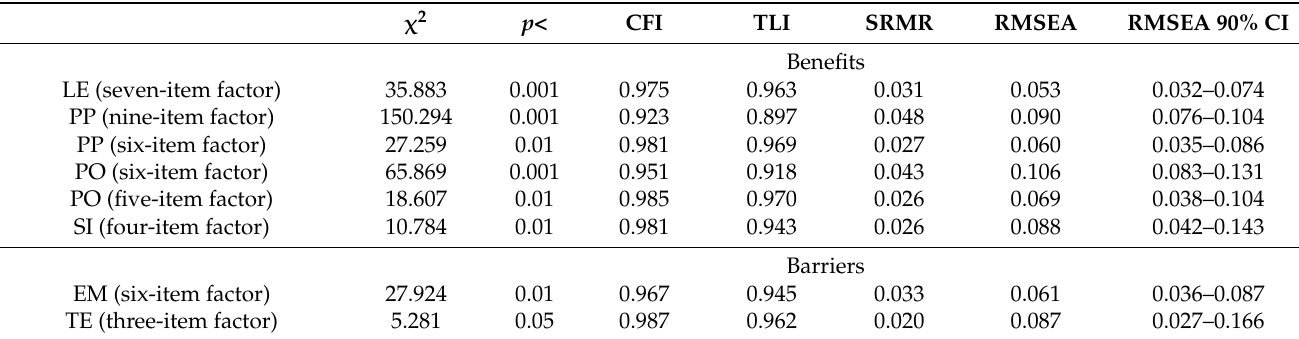
Table 3. Congeneric model testing.